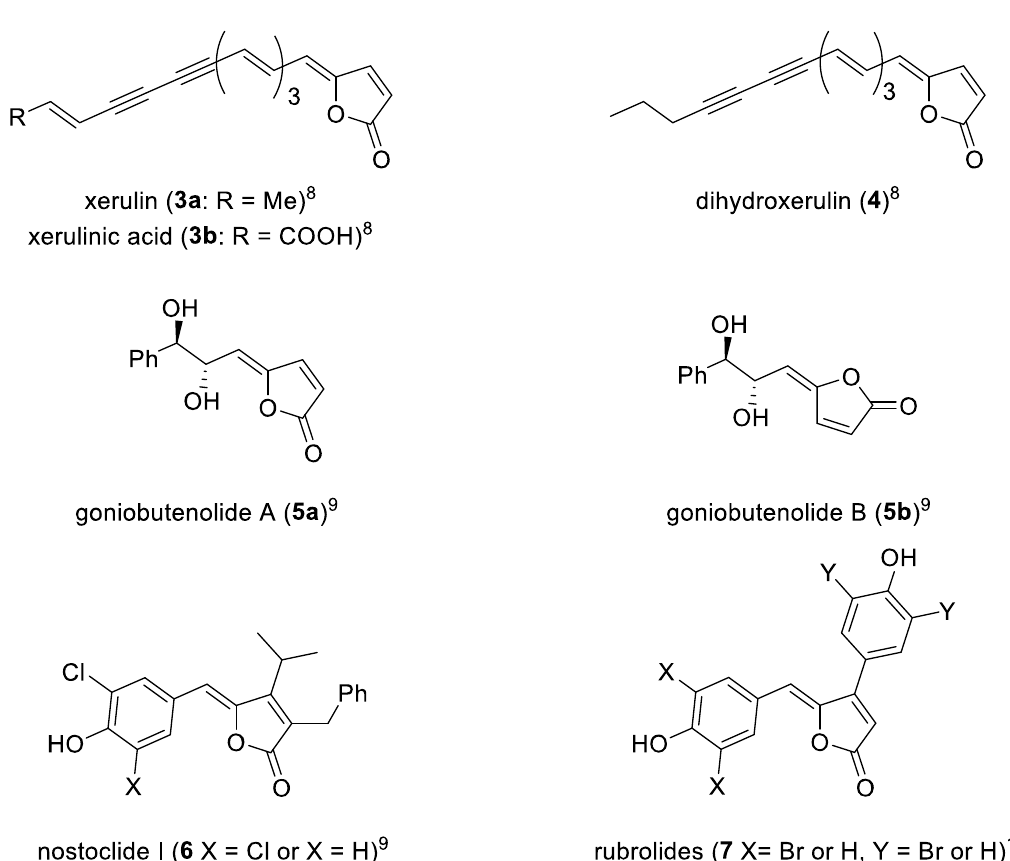
Figure 2. Some representative γ -alkylidenebutenolides.